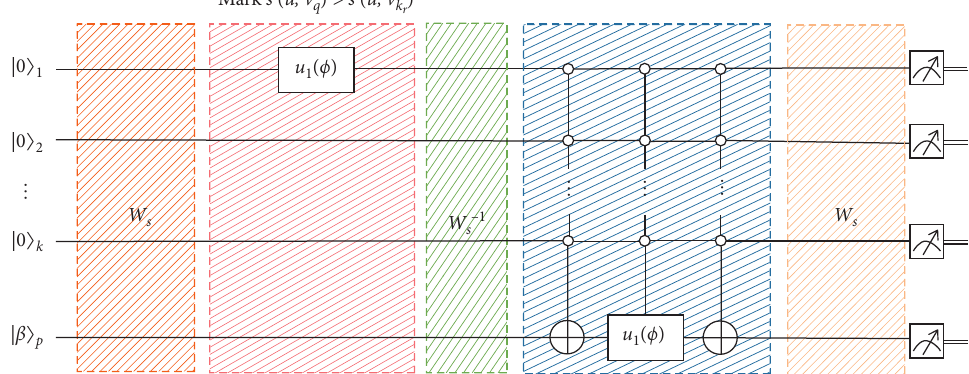
Figure 5: Quantum circuit with one iteration in Grover–Long method [35]; q [ 0 ] denotes the highest qubit and q [ n − 1 ] denotes the lowest qubit.